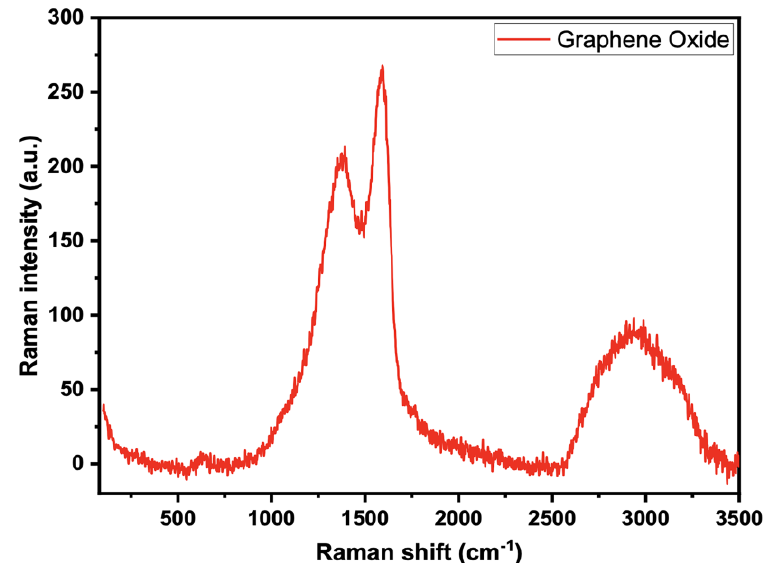
Figure 3. Raman spectra for graphene oxide.